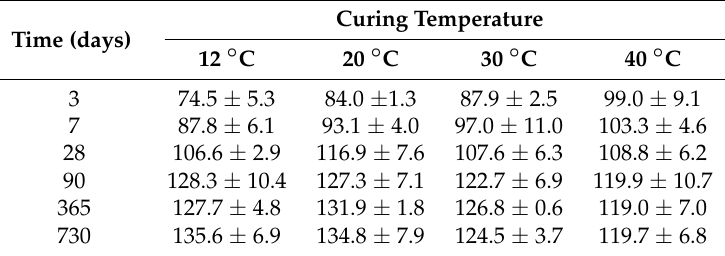
Table 7. Results of compressive strength tests (MPa) of concrete samples cured at 12 ◦ C, 20 ◦ C, 30 ◦ C and 40 ◦